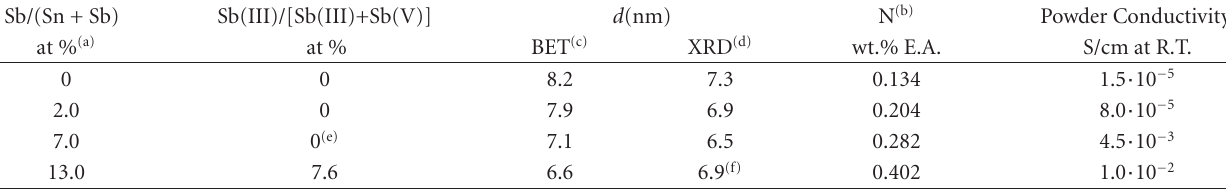
Table 1: Properties of the Sb:SnO 2 particles used